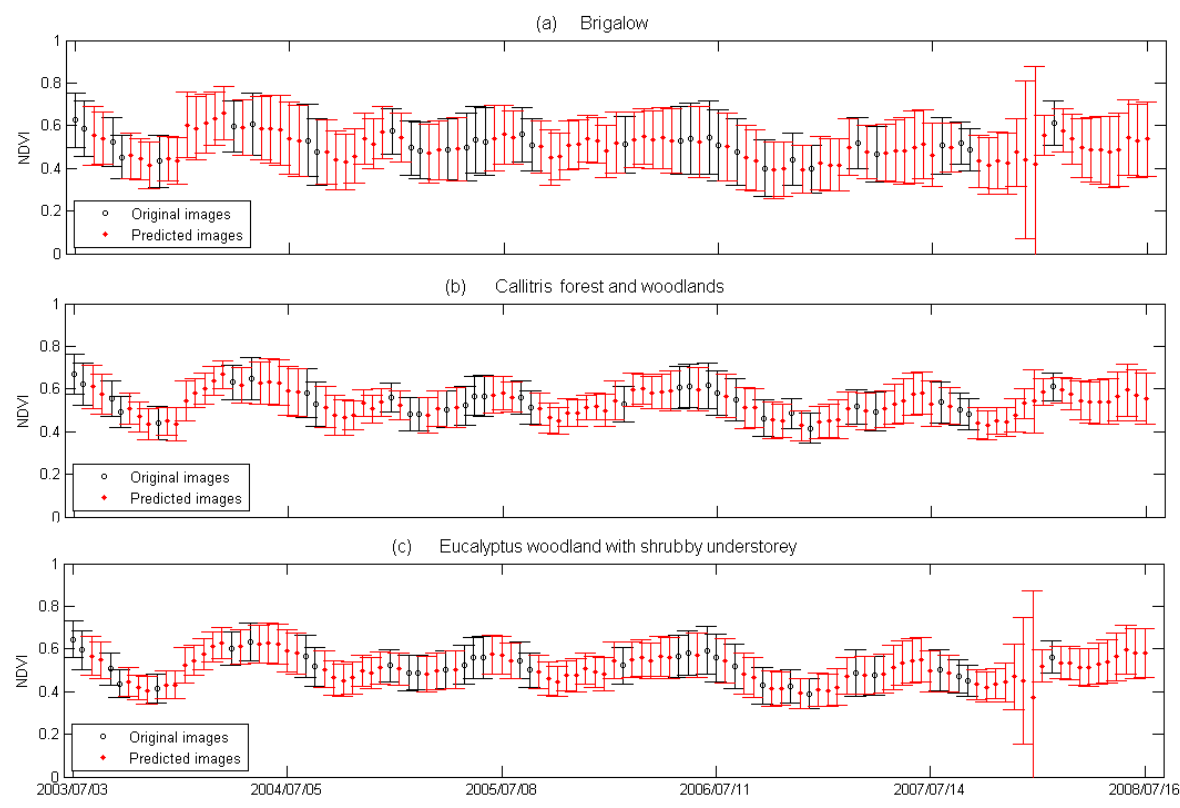
Figure 8. Time series of mean NDVI values derived from LITS for three different vegetation communities ( a ) Brigalow, ( b ) Callitris forests and woodlands and ( c ) Eucalyptus woodlands with shrubby understorey. The circles show the mean NDVI from the original images and the asterisks show the value from predicted images. The corresponding error bars show the standard